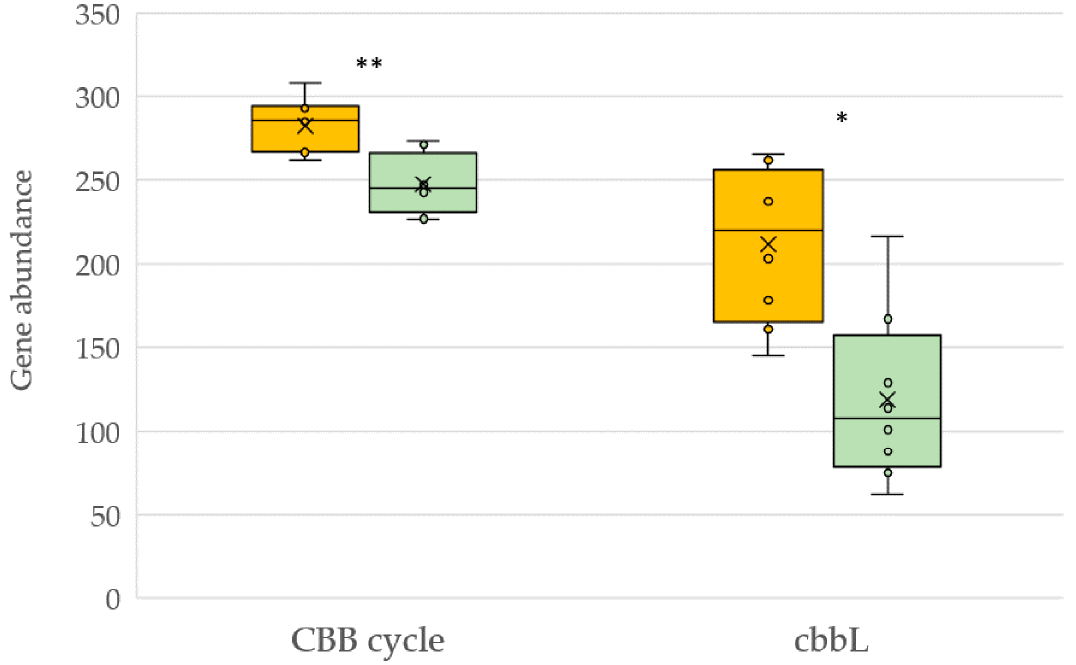
Figure 8. KEGG pathway molecular functions of carbon fixation for soils under conventional (yellow) and organic (green) management. CBB: Calvin-Benson-Bassham cycle; cbbL : ribulose-bisphosphate carboxylase [EC 4.1.1.39]. Asterisk represents a significant difference (** p < 0.01, * p < 0.05).